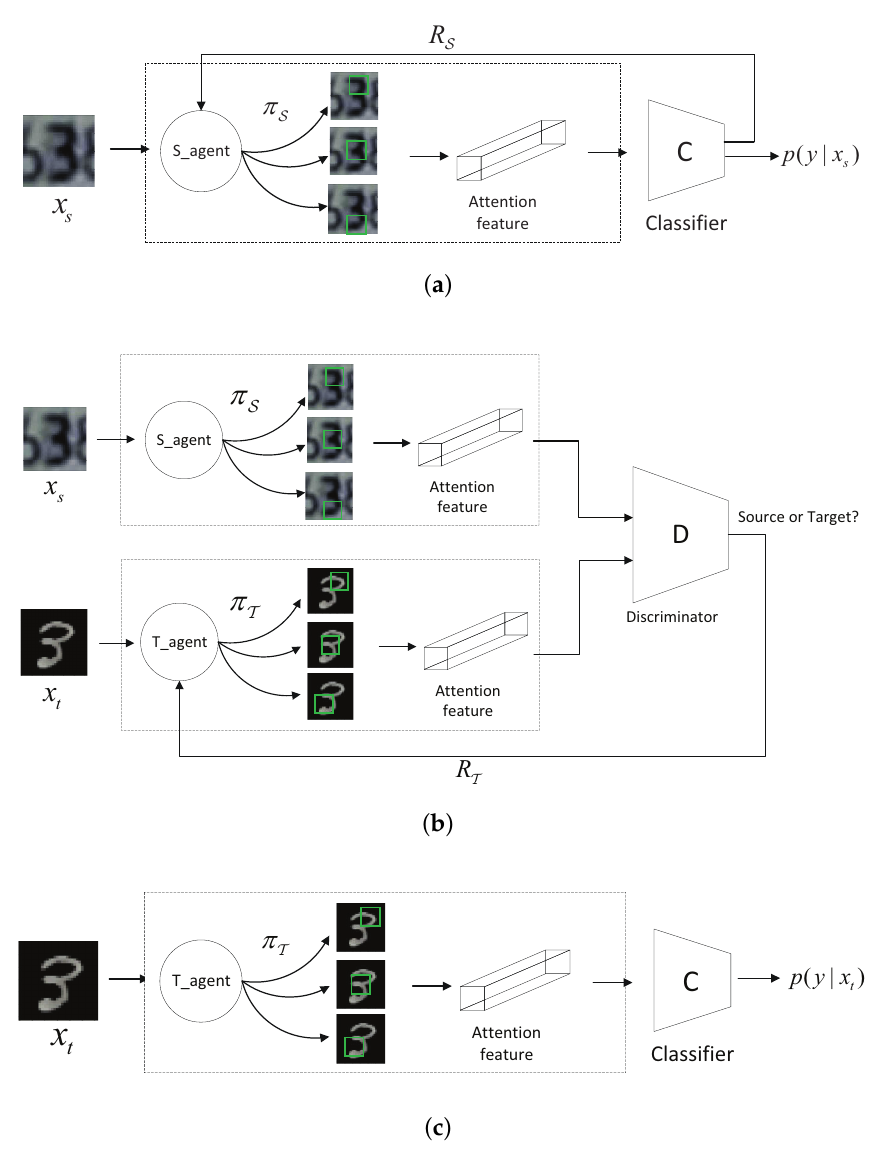
Figure 3. The complete framework of adversarial hard attention adaptation. ( a ) Pre-training the source agent S and the Classifier C in the source domain; ( b ) Adversarial learning of the target agent T and the Discriminator D in the target domain; ( c ) Testing in the target